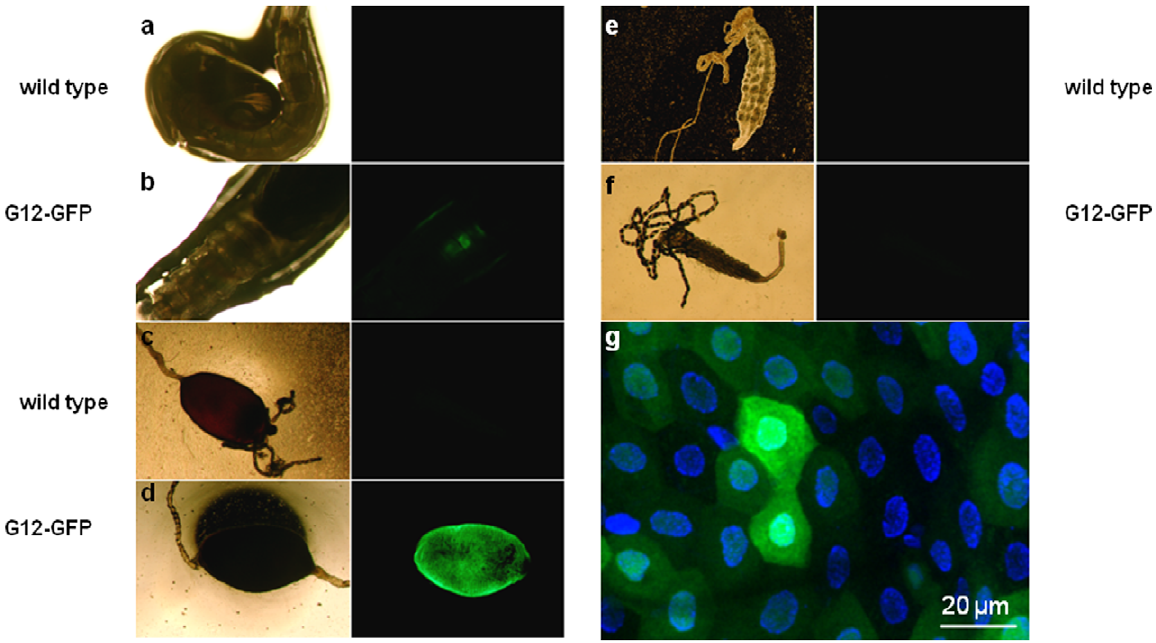
Figure 4. EGFP driven by the G12 promoter accumulates in the midgut epithelium. Pupae ( a , b ), 24 h PBM midguts ( c , d ) and unfed female midguts ( e , f ) from wild type mosquitoes and a pG12::EGFP transgenic line (F6 1 ) were visualised under transmission light (left panel) or epifluorescence (right panel). Reconstruction of a series of optical z-sections obtained by the Zeiss Apotome-assisted fluorescence microscopy ( g ) of 24 h PBM midguts dissected from transgenic mosquitoes reveals patchy distribution of EGFP-positive cells (green) across the epithelium. Cell nuclei are stained with DAPI (blue).